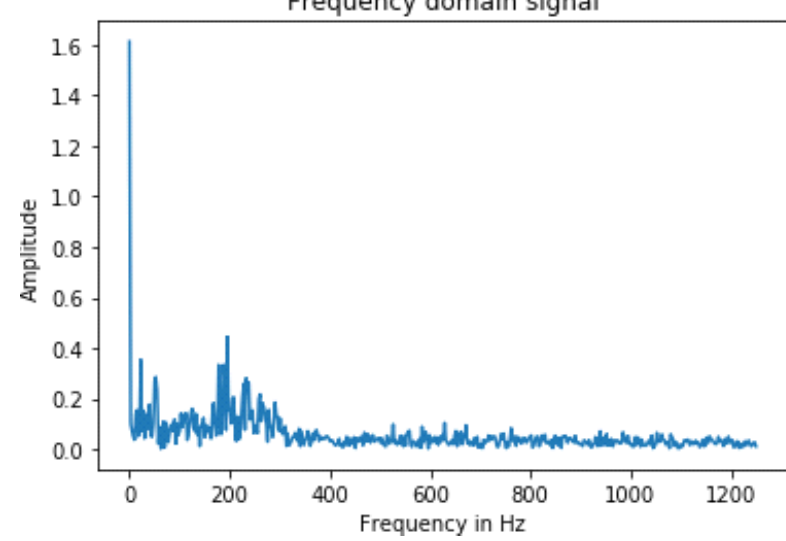
Figure 6: A sample signal representation of good conditioned aircraft gearbox system in frequency domain